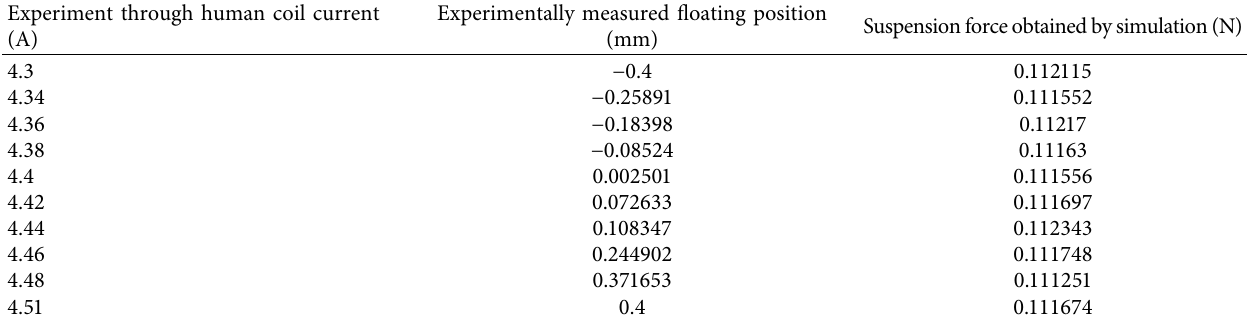
Table 1: Suspension force obtained by the simulation.